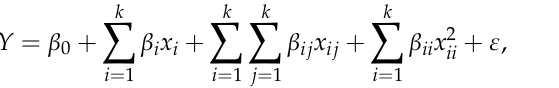
Figure A5. Rietveld refinement plot of sample containing jarosite as the major phase (blue line—observed intensity at each step; red line—calculated pattern; solid grey line, below, difference between observed and calculated intensities; vertical bars, positions of all Bragg reflections).